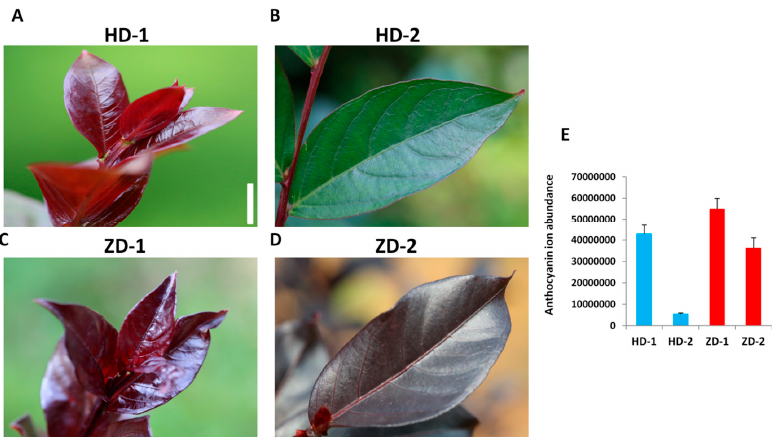
Figure 1. The phenotypes of young ( A , C ) and mature ( B , D ) leaves of HD and ZD. The bar represents 1.2 cm. ( E ) Total anthocyanin content measured in leaves of HD and ZD at young (Stage 1, S1) and mature (Stage 2, S2) stages. HD represents the cultivar Lagerstroemia Dynamite, while ZD represent the cultivar Lagerstroemia Ebony Embers. Data are from three replicate samples and represent the ion abundance of the anthocyanin compounds. Table 1. Concentration of the anthocyanins detected in the two L. indica cutlivars and their log2 fold-change values. Bold values are those significantly changed between compared samples.